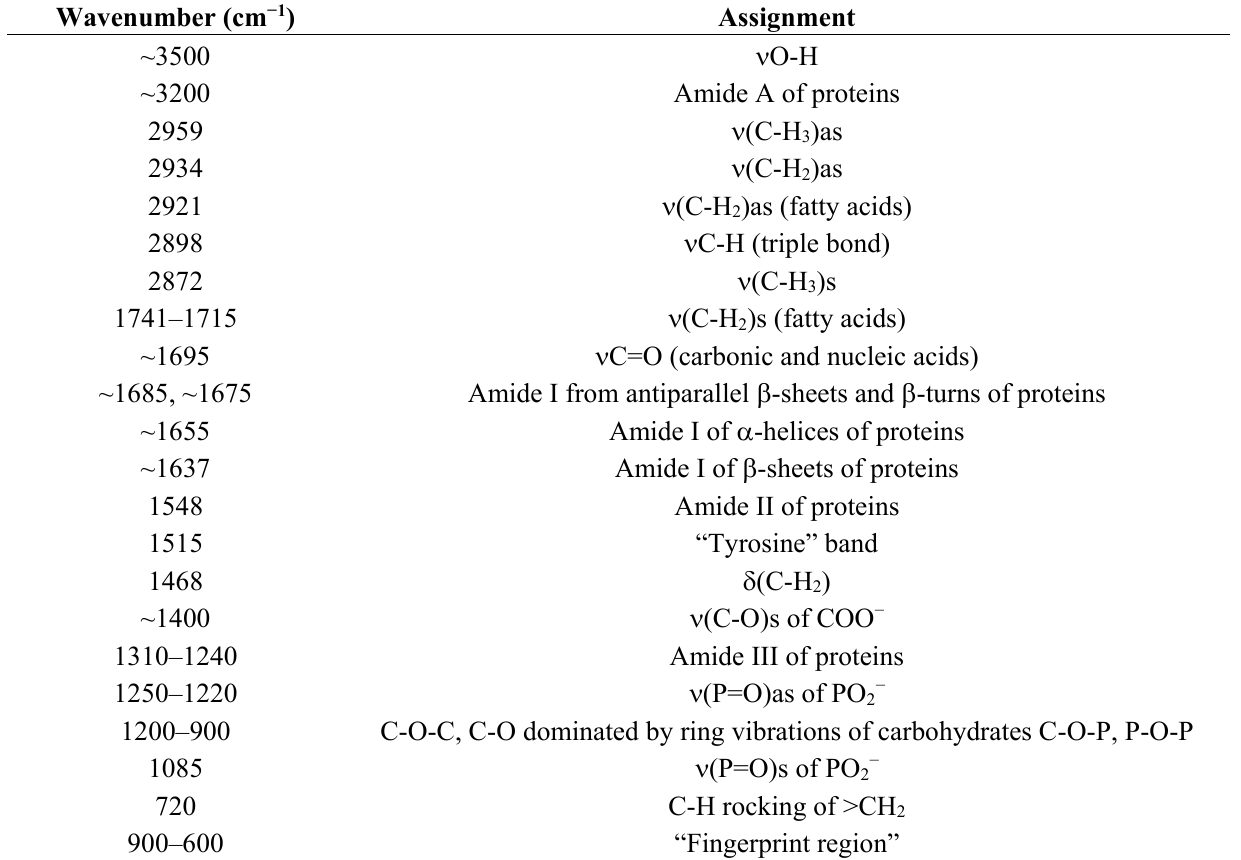
Table 1. Assignment of the main bands generally found in Fourier Transform Infrared Spectroscopy (FTIR) spectra of biological samples a